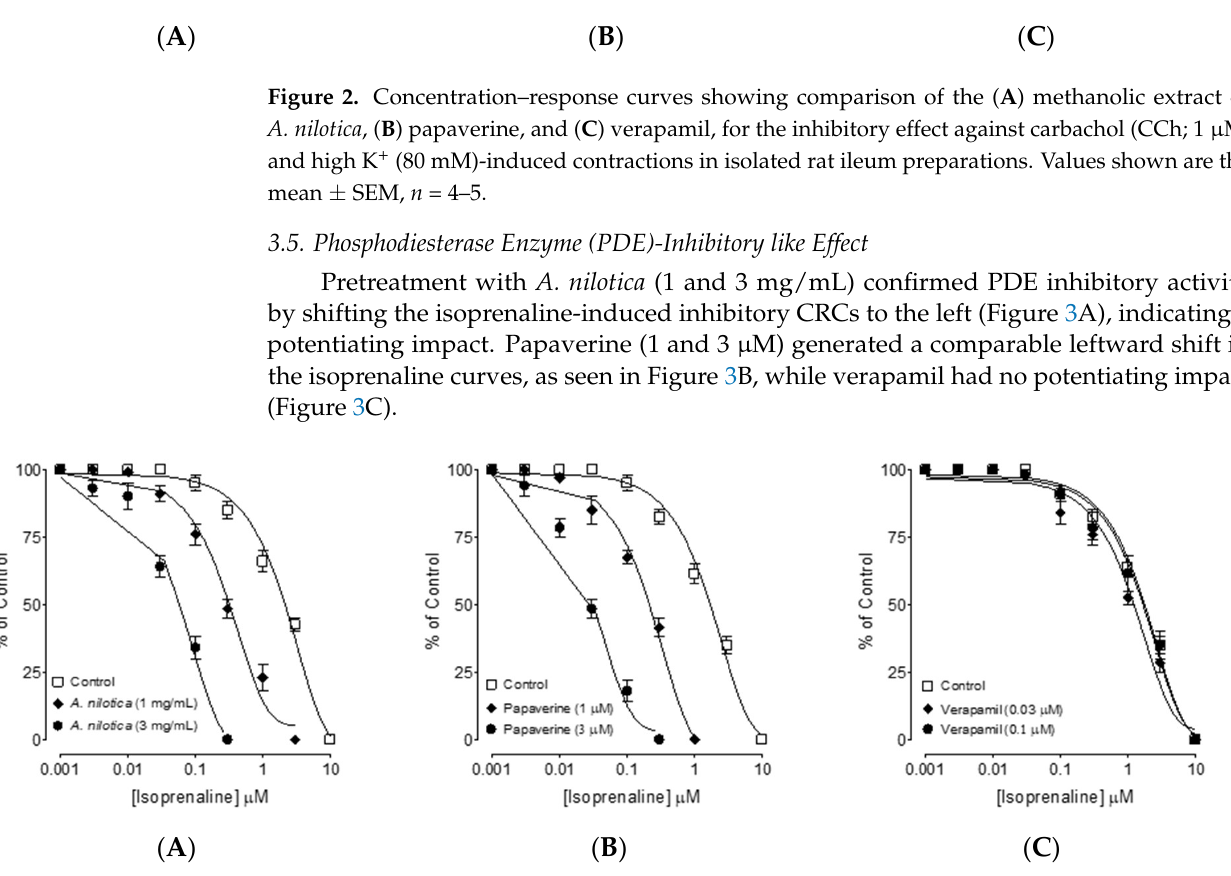
Figure 3. Inhibitory concentration–response curves of isoprenaline against carbachol (CCh)-induced contractions in the absence and presence of different concentrations of ( A ) the methanolic extract of A. nilotica , ( B ) papaverine, and ( C ) verapamil in isolated rat ileum preparations. Values shown are the mean ± SEM, n = 4–5. To confirm the Ca ++ inhibitory activity, preincubation of ileum tissues with A. nilotica methanolic extract skewed the Ca ++ CRCs curves at tested dosages of 3 and 5 mg/mL (Figure 4A) towards the right with suppression of the maximum effect. Similarly, ve- rapamil and papaverine, at respective preincubated concentrations (0.01 and 0.03 µ M; verapamil) and (1 and 3 µ M; papaverine), also deflected Ca ++ curves towards the right with suppression of the highest peaks as shown in Figure